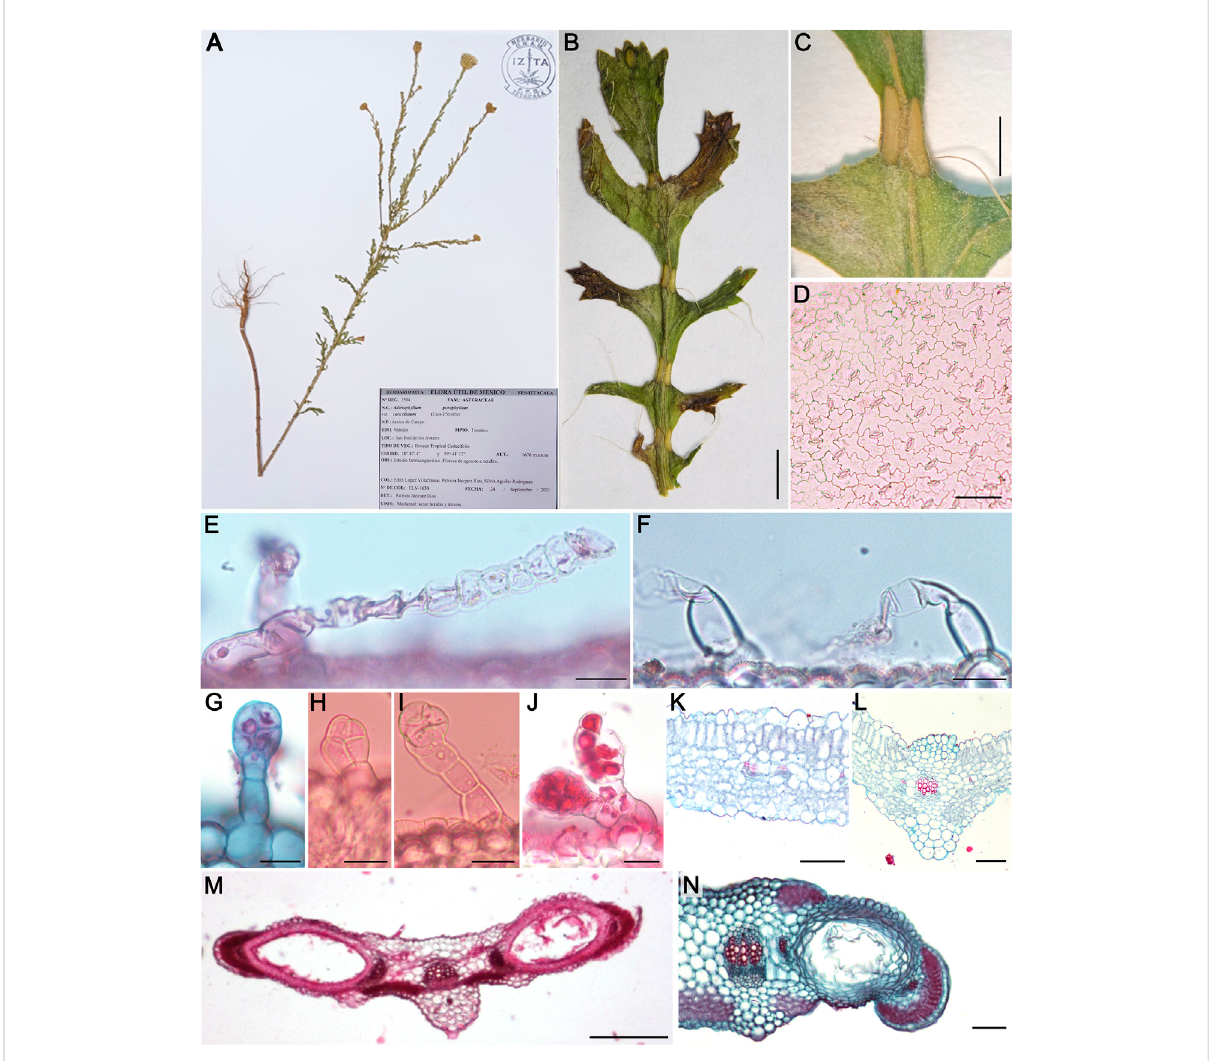
FIGURE 1 Morpho-anatomicalcharactersof Adenophyllumporophyllum var. cancellatum :HerbariumspecimenNo. 3504-IZTA (A) ,leafmorphology (B) , elliptical glands (C) , super fi cial view of abaxial epidermis (D) , uniseriate simple trichomes (E,F) , glandular trichomes (G – J) , transverse view of leaf anatomy ( K , L ), glands anatomy ( M , N ). Bars: (B) = 3 mm, (C) = 1 mm, ( D,K,L,N ) = 100 μ m, (E − J) = 25 μ m, (M) = 250